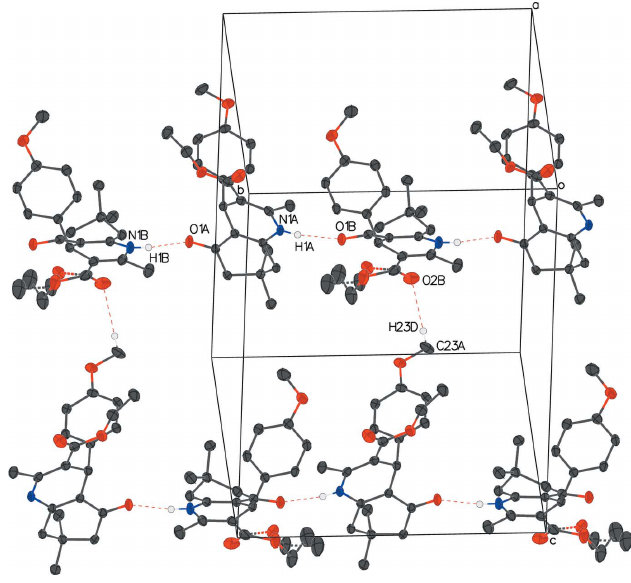
Figure 4 The packing of compound I. Intermolecular hydrogen bonds are shown as dashed lines, and H atoms not involved in these hydrogen bonds are removed for clarity.